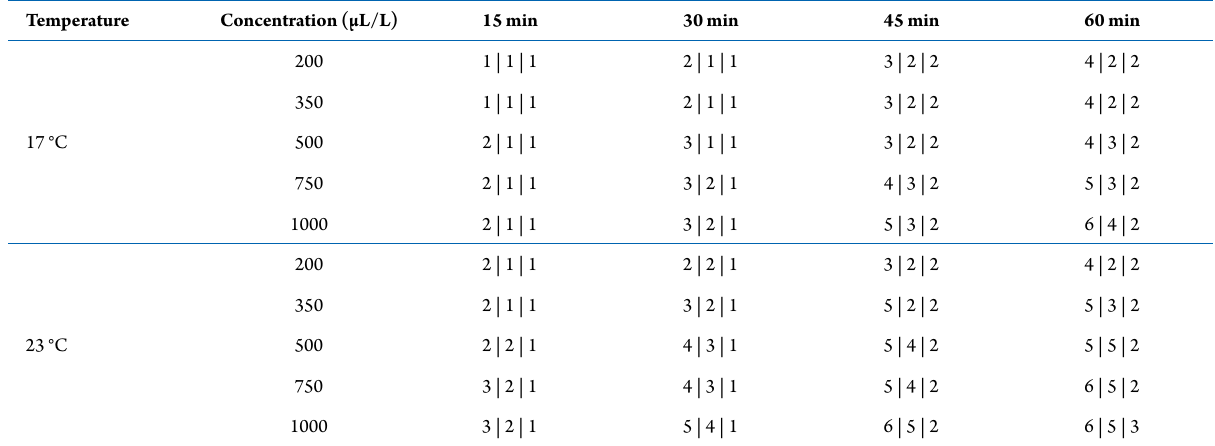
Note: The significances between the concentrations were analyzed using one-way ANOVA. Different letters in the same column indicate the statistical differences between the concentrations for induction times at 17 and 23 °C ( p < Table 3. The 15 min induction stages of red swamp crayfish exposed to clove (CLO) spearmint (SPO), and chamomile (CHO) oils for 1 h.